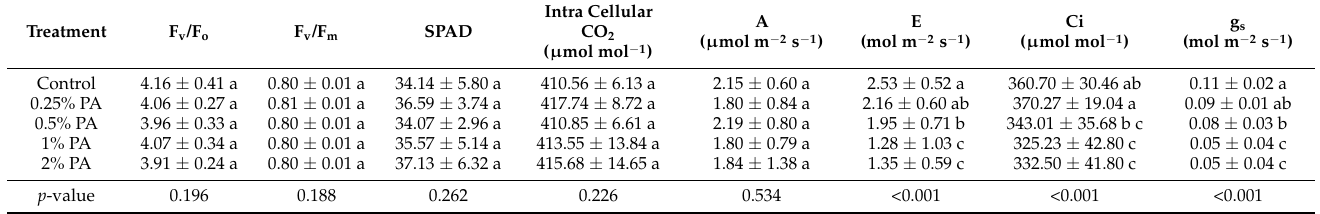
Table 2. Physiological response of tomato ‘Scotia’ plants treated with pyroligneous acid